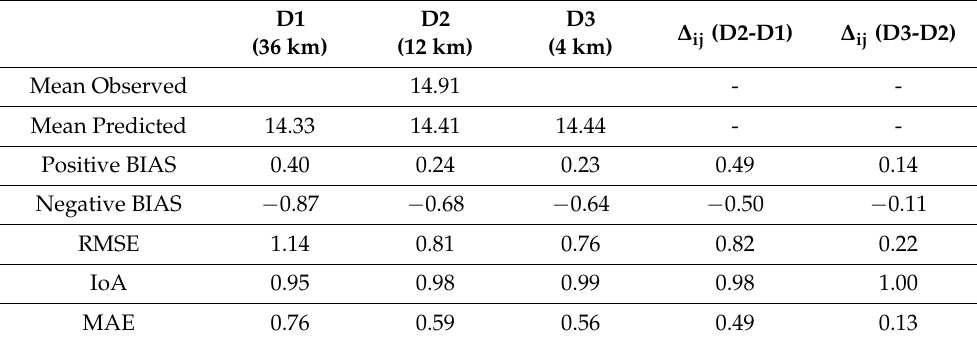
Table 4. Annual maximum temperature statistical analysis ( ◦ C).